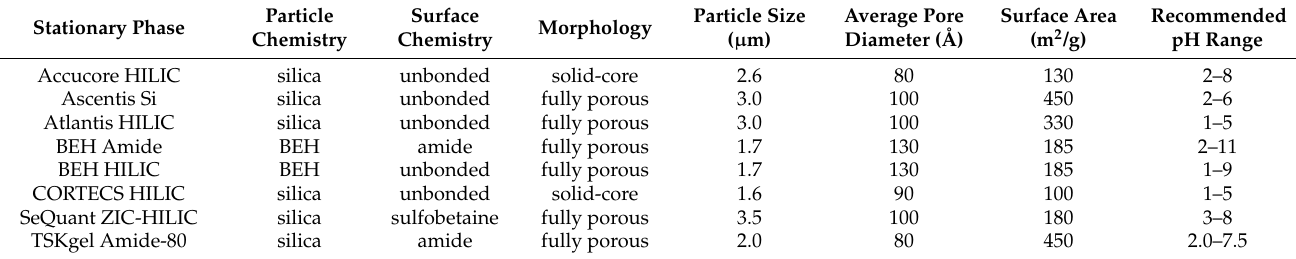
Table 3. Chemical and physical properties of the stationary phases evaluated.